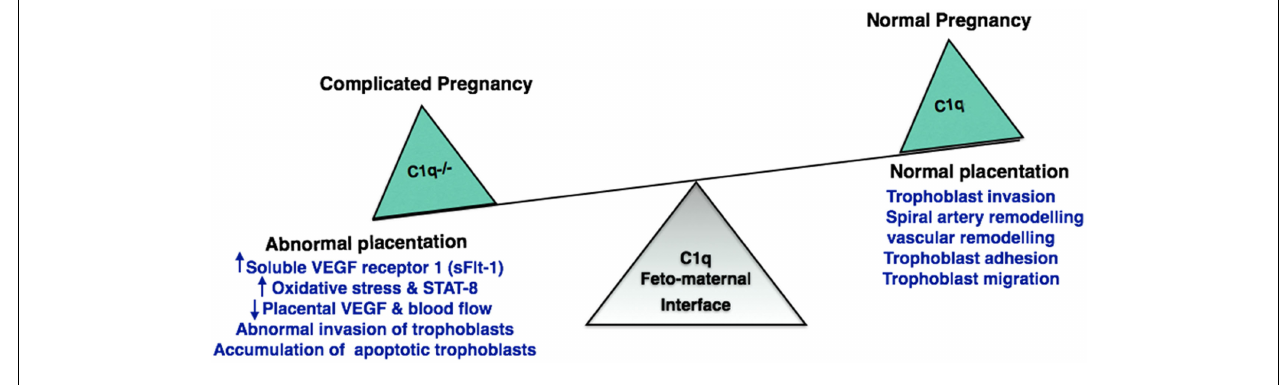
the generation of placental vascular endothelial growth factor (VEGF) and blood flow, resulting in implantation failure and pregnancy complications such as recurrent pregnancy loss, miscarriage, abortion, and